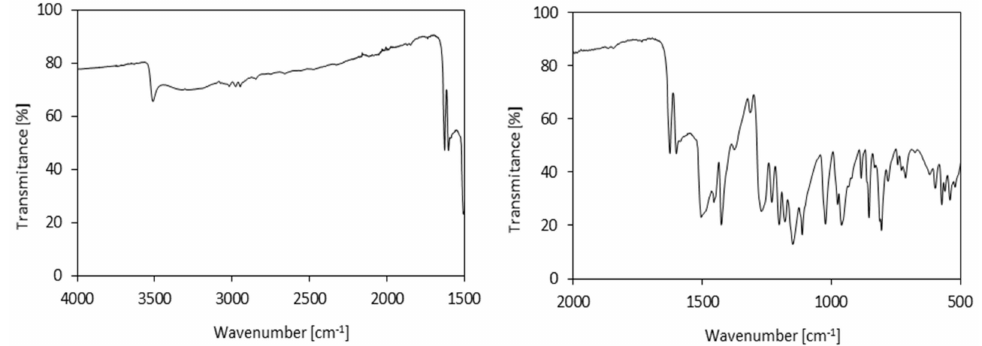
Figure 3. Fourier-transform infrared spectroscopy (FTIR) spectra of clove filler.